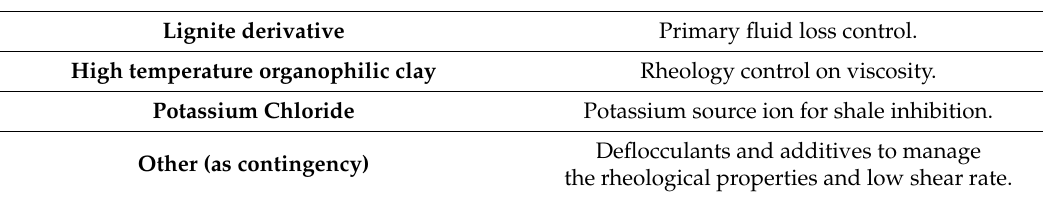
Table 10. Drilling fluids and its function for the drilling of 8 1